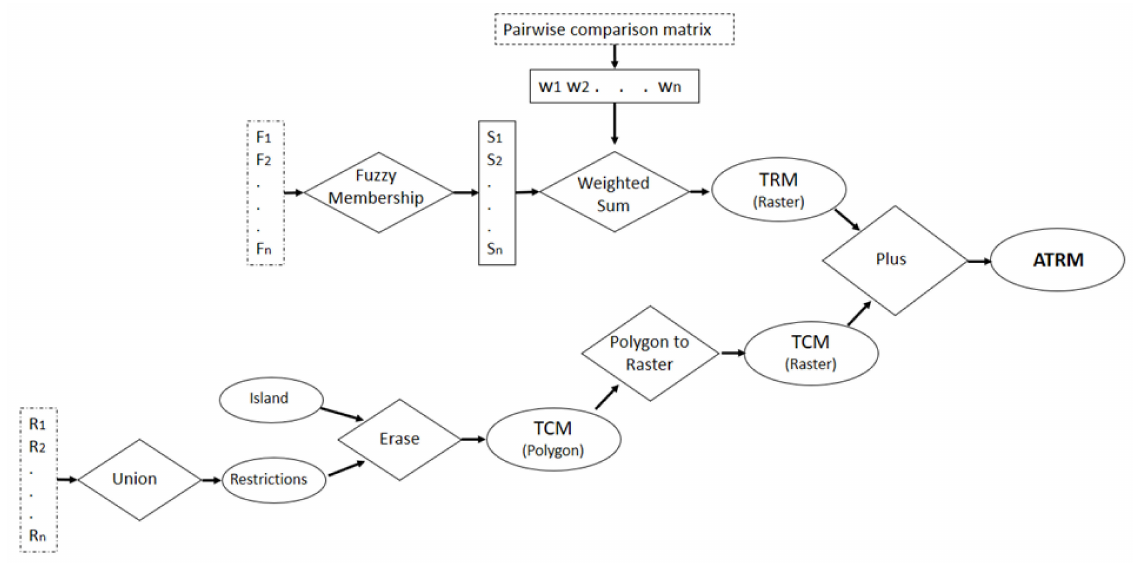
Figure 3. Geographic information system (GIS) model for stages 3 and